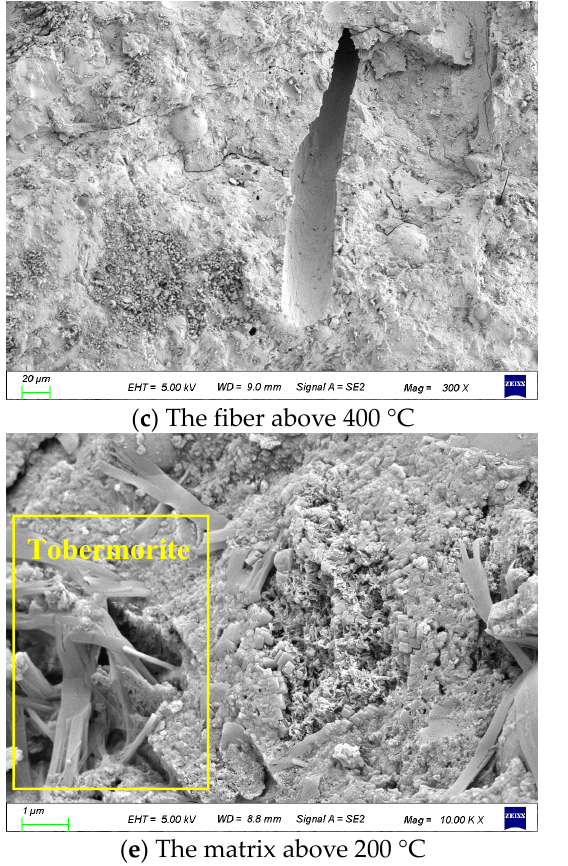
Figure 14. Surface condition after exposure to high temperatures and self-healing under clean water.